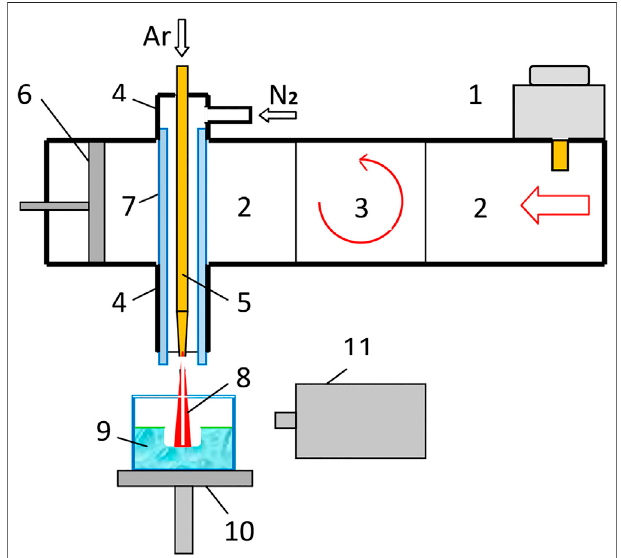
FIGURE 1 | Schematic diagram of the microwave device for plasma activation of liquids: 1 – magnetron Samsung OM75P (31), 2 – rectangular waveguide of a cross-section (45 × 90 mm 2 ), 3 – ferrite isolator, 4 – coaxial waveguide, 5 – central conductor of the coaxial line with a nozzle at its end, 6 – tuning piston, 7 – quartz pipe, 8 – plasma jet, 9 – water target in a quartz cell, 10 – cell holder, 11 – spectrometer AvaSpec-3648-USB2.